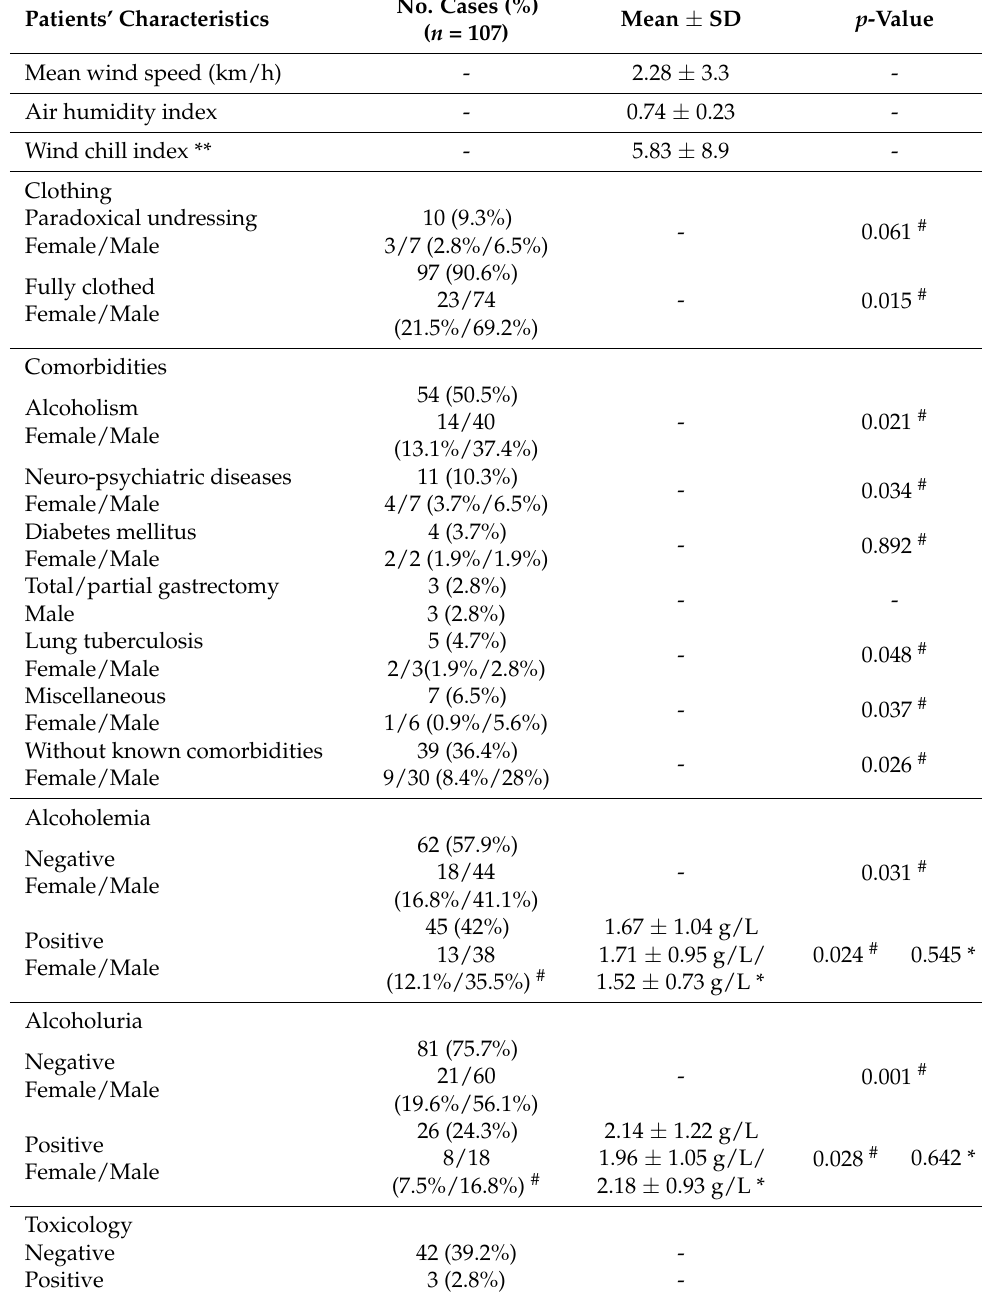
Table 2. Cont . Patients’